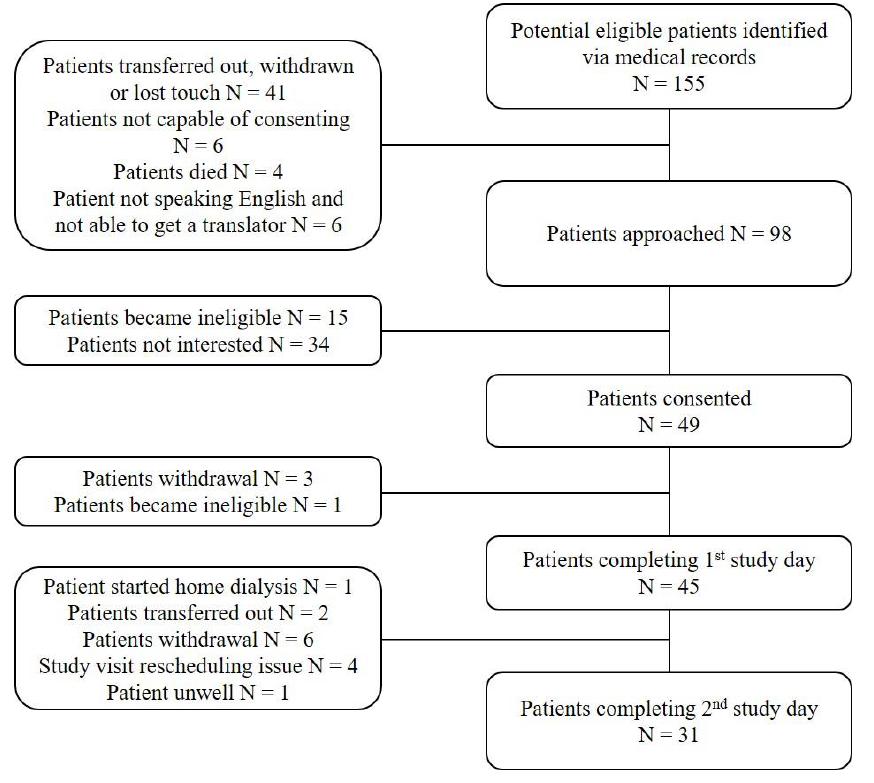
Figure 1. Study flow chart. Table 1. Characteristics of the study population (n =